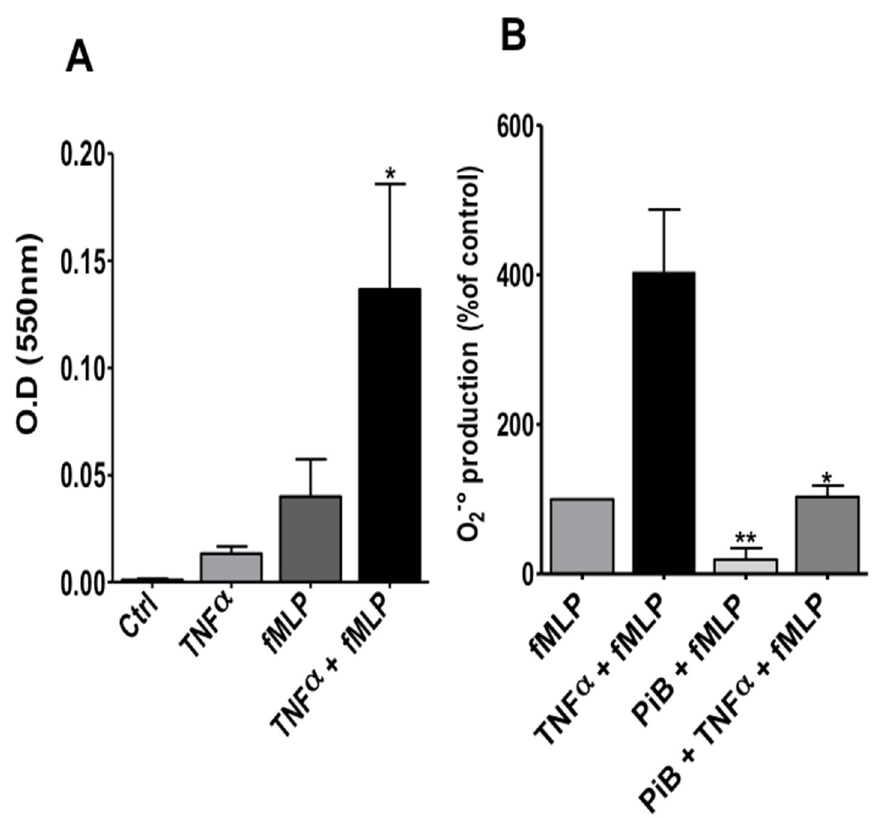
Figure 7. Effect of PiB on superoxide anion production by human neutrophils. ( A ) Neutrophils (1 × 10 6 /mL HBSS) were incubated in the absence or presence of TNF α (20 ng/mL) for 20 min before stimulation with fMLP (10 − 7 M). Superoxide production was determined by measuring ferricytochrome c reduction at 550 nm over 10 min at 37 °C. ( B ) Neutrophils (1 × 10 6 /mL HBSS) were incubated without or with PiB (50 μ M) for 30 min, then treated or not with TNF α (20 ng/mL) for 20 min before stimulation with fMLP (10 − 7 M) and superoxide production was determined by measuring ferricytochrome c reduction at 550 nm over 10 min at 37 °C. Data are means ± S.E.M. of 3 separate experiments (* p < 0.05; ** p < 0.01).